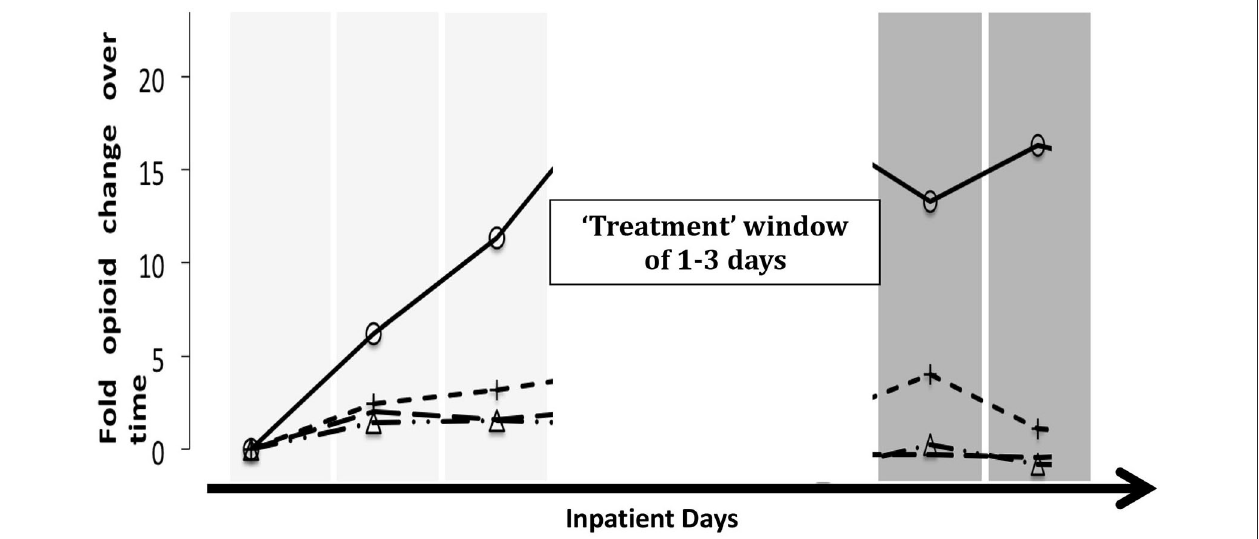
FIGURE 1 | Schematic of analysis. Patient comparisons were complicated as infused patients had a window of treatment and, thus, point of reference that was not naturally occurring in non-infused patients. To account for this, we randomly chose a reference day from control encounters and randomly assigned a window (length) of treatment. In order to give a visual explanation of the way the analysis of the “no infusion” group defined the treatment window, four randomly selected patients with different trajectories for MME were chosen; as such, each line represents a patient.